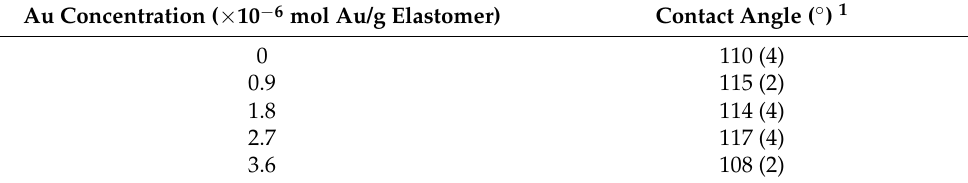
Table 1. Contact angle values for the PDMS samples containing increasing quantities of embedded GNS. Au Concentration ( × 10 − 6 mol Au/g